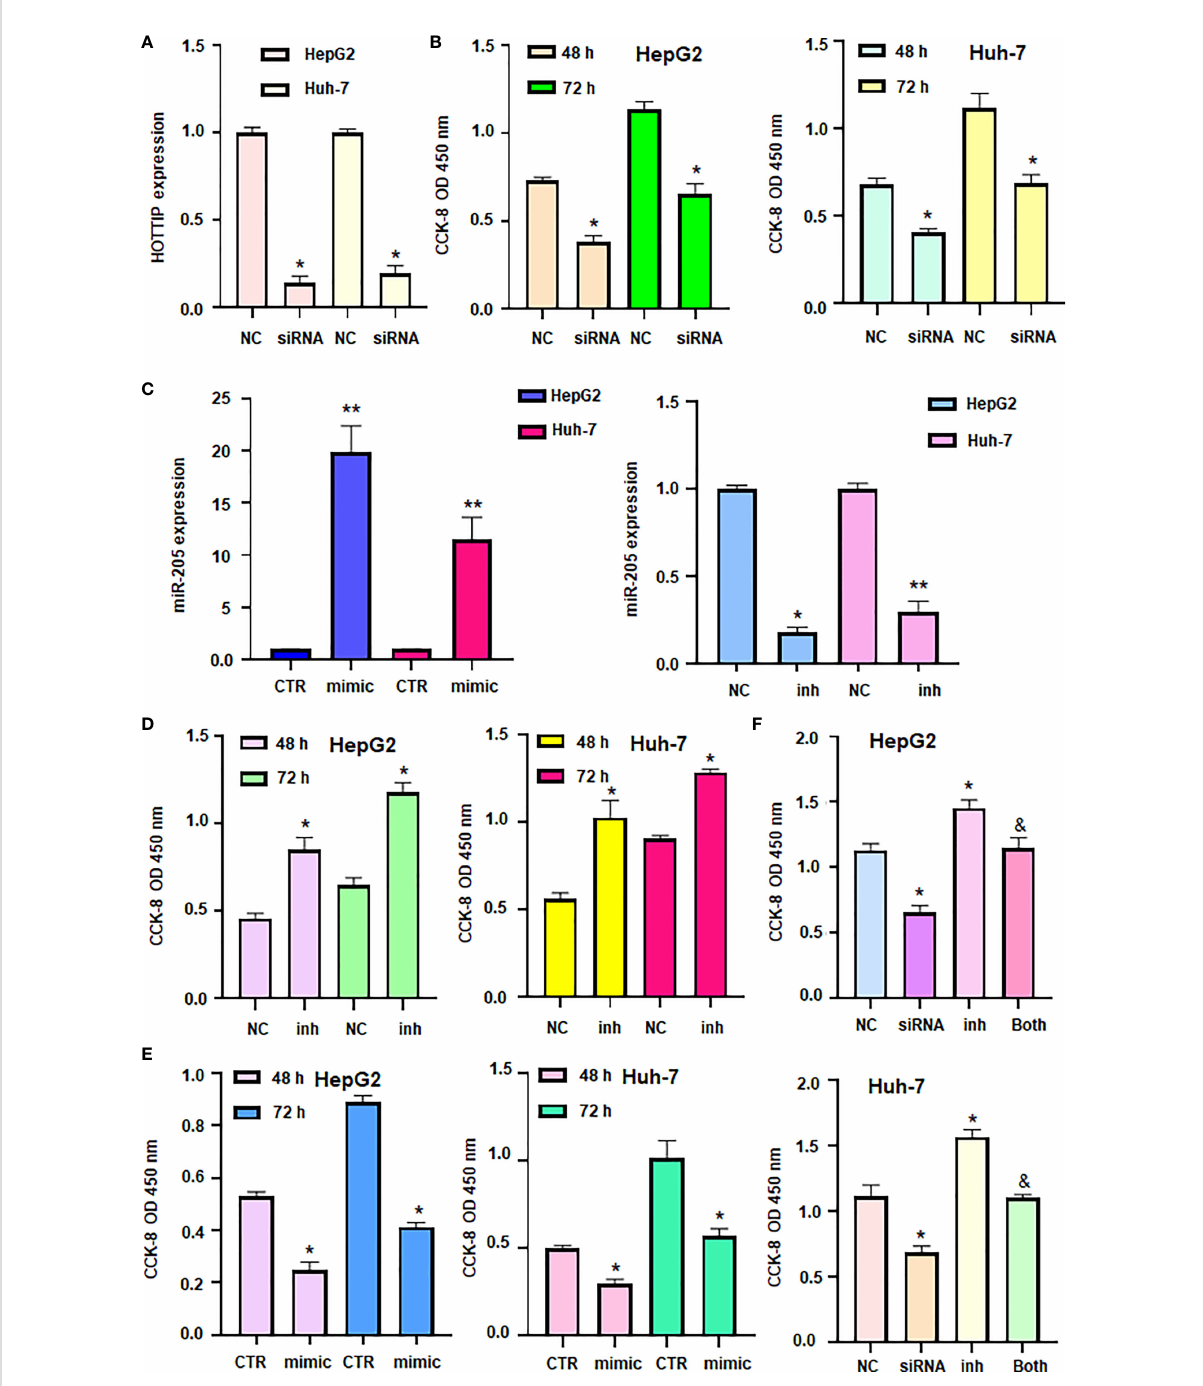
FIGURE 8 LncRNA HOTTIP promoted cell viability via miR-205 in HCC. (A) RT-PCR was done to measure the expression of HOTTIP in HCC cells after HOTTIP siRNA transfection. (B) CCK8 assay was done to measure cell viability in HCC cells after HOTTIP siRNA transfection. (C) : RT-PCR was done to measure the expression of miR-205 in HCC cells after miR-205 inhibitor or mimics transfection. (D, E) CCK8 assay was done to measure cell viability in HCC cells after miR-205 inhibitor or mimics transfection. (F) CCK8 assay was done to measure cell viability in HCC cells after HOTTIP siRNA transfection or miR-205 inhibitor or combination treatments. NC, negative control; inh, inhibitor; CTR, control. *P < 0.05; **P < 0.01 compared with NC or CTR; &P<0.05 compared with siRNA alone or inhibitor